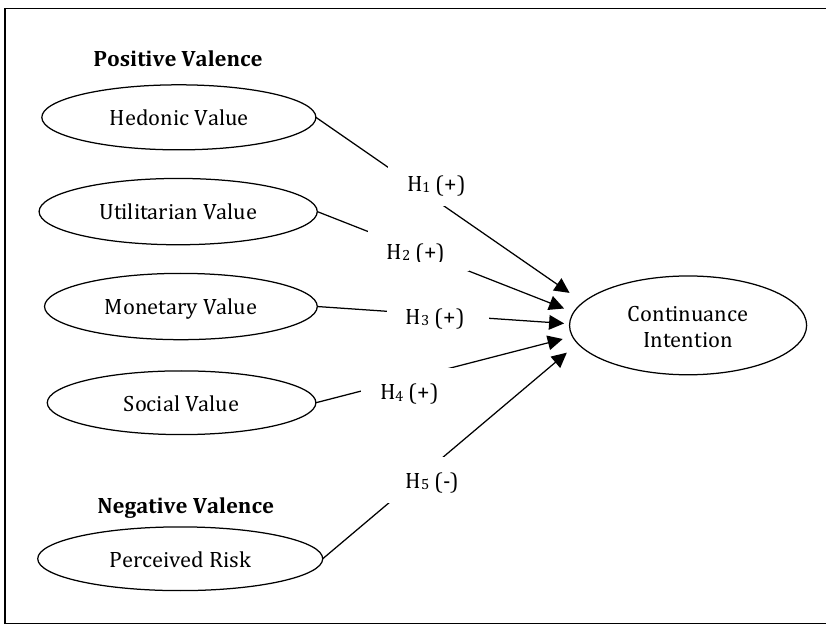
Figure 1: Conceptual